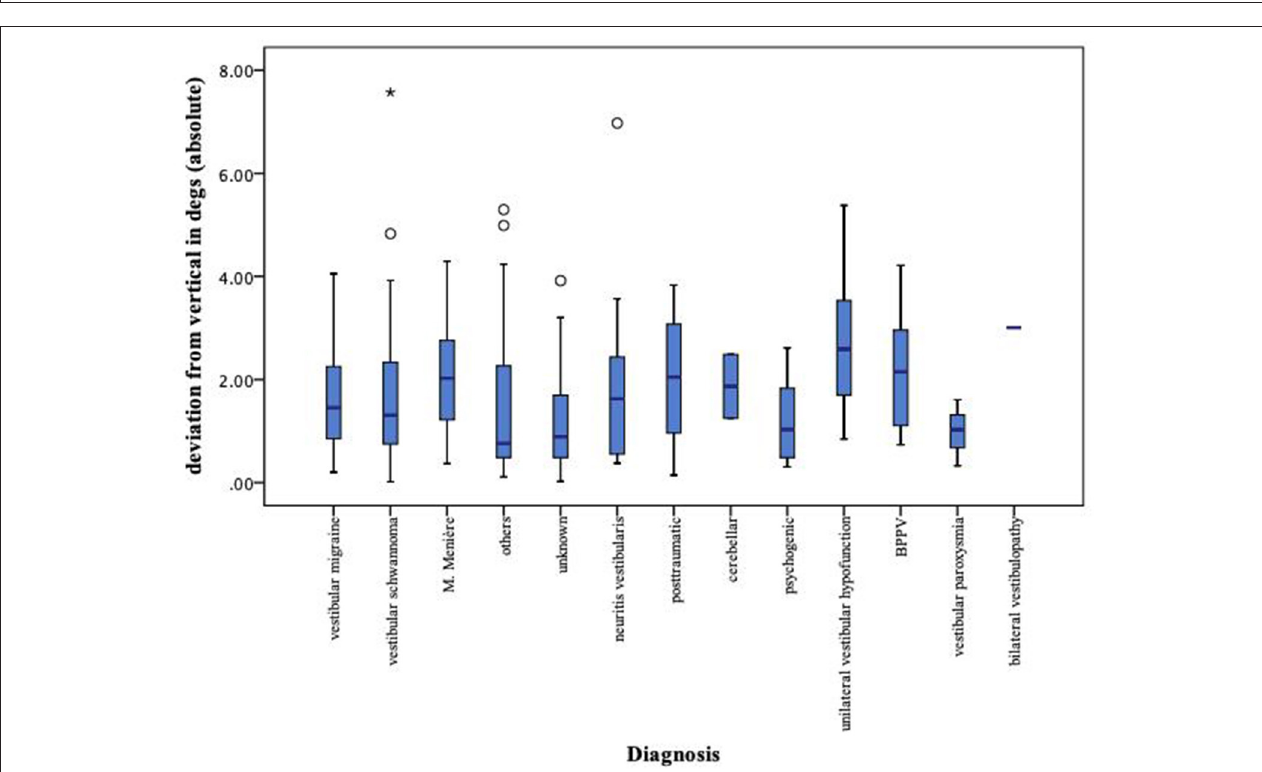
FIGURE 8 | Boxplot of SVV measurements for each diagnosis separately. SVV, subjective visual vertical; left-sided values (original data = < 0) and right-sided values (original data = > 0) both expressed as positive values. *Extreme value, below quartile 1 or above quartile 3.